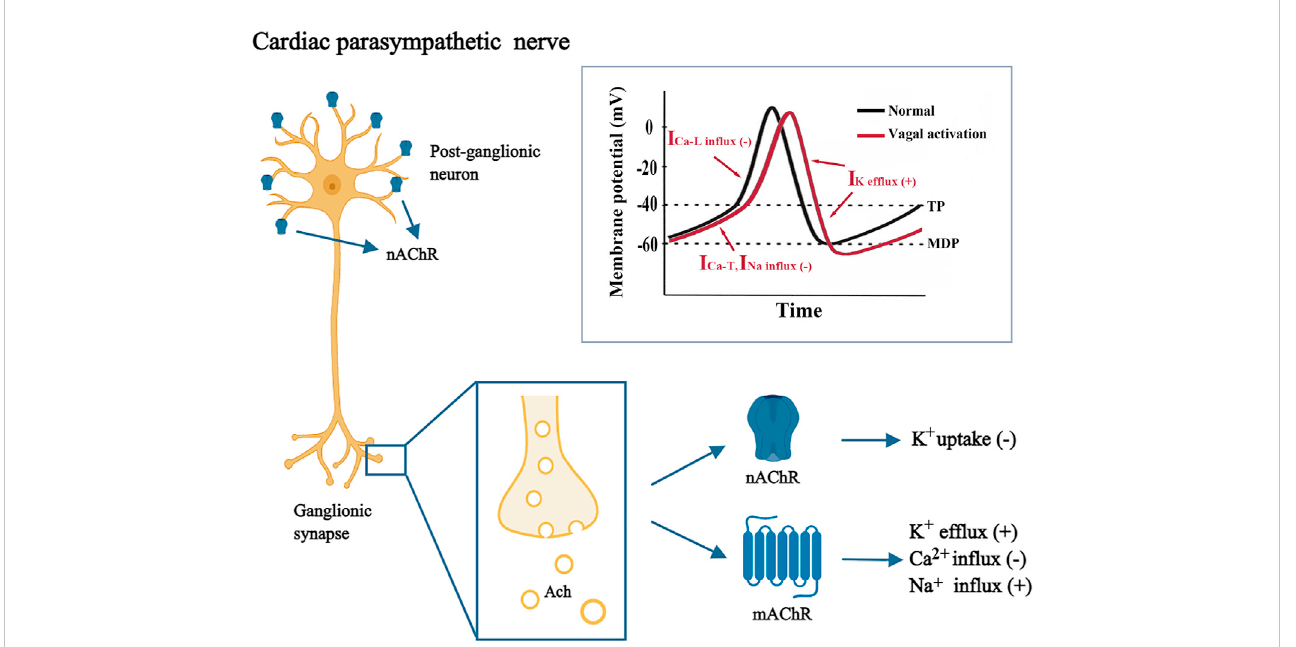
FIGURE 1 Mechanism underlying vagal-induced sinus node dysfunction. The gray box shows the waveform of sinoatrial node action potentials under normal condition and during vagal activation. ACh, acetylcholine; I Ca-L , L-type calcium current; I Ca-T , T-type calcium current; I Na , sodium current; I K , potassium current; Ca 2+ , calcium ion; K + , potassium ion; MDP, maximum negative diastolic potential; mAchR, muscarinic acetylcholine receptor; Na + , sodium ion; nAChR, nicotinic acetylcholine receptor; TP, threshold